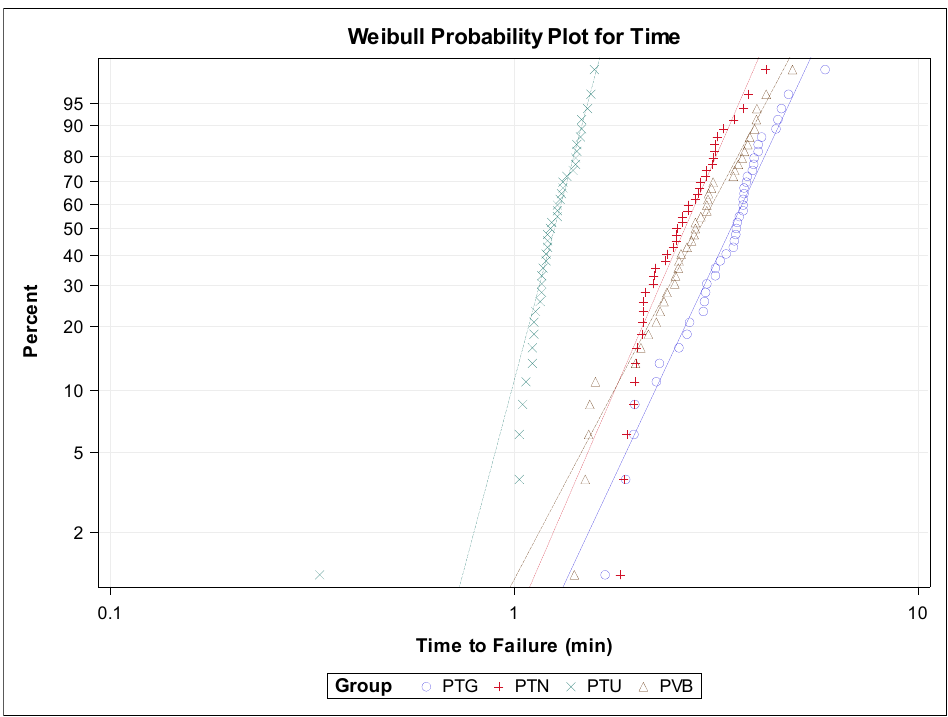
Figure 4. Weibull probability plot of time to failure for the study groups.